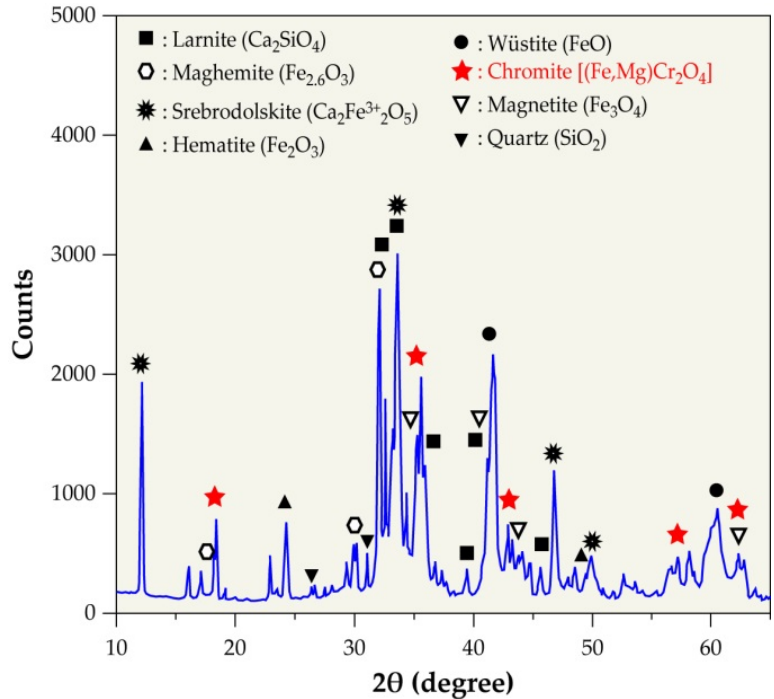
Figure 5. X ‐ ray diffraction (XRD) pattern of EAF slags.